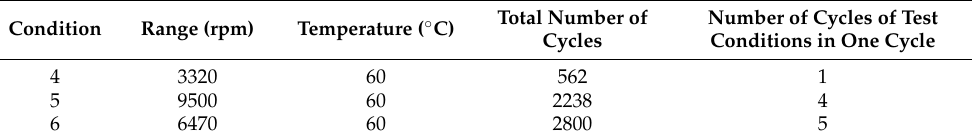
Table 8. Number of cycles for each test condition in alternating loads fatigue mode.